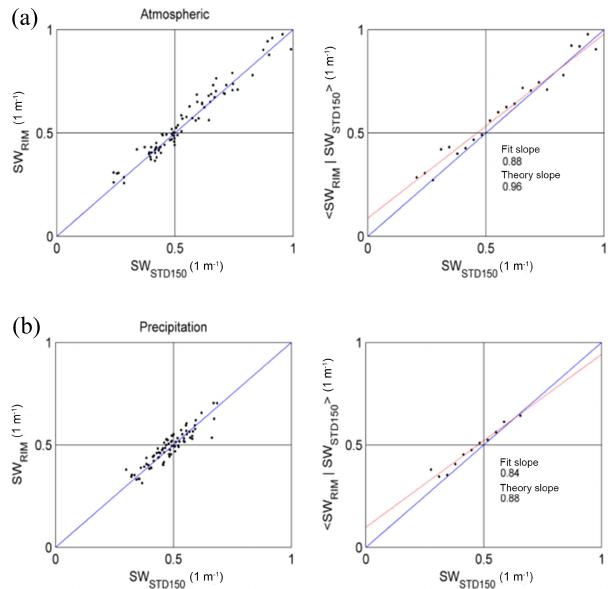
Figure 9. Results of the conditional averaging like those in Fig. 7b and c, except that spectral widths are shown (red line is the fit slope).